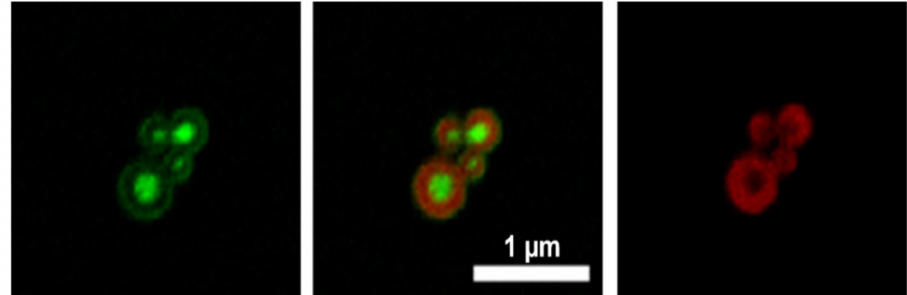
Figure 6. Representative confocal microscopy images for HByp4 with encapsulated 40 K MW dextrans. Fluorescein-labeled dextrans encapsulated mostly within the interior of the assemblies ( left ), with shells of the structures stained with Congo Red ( right ), and an overlap of both channels ( center ). Scale bar: 1 µ m.